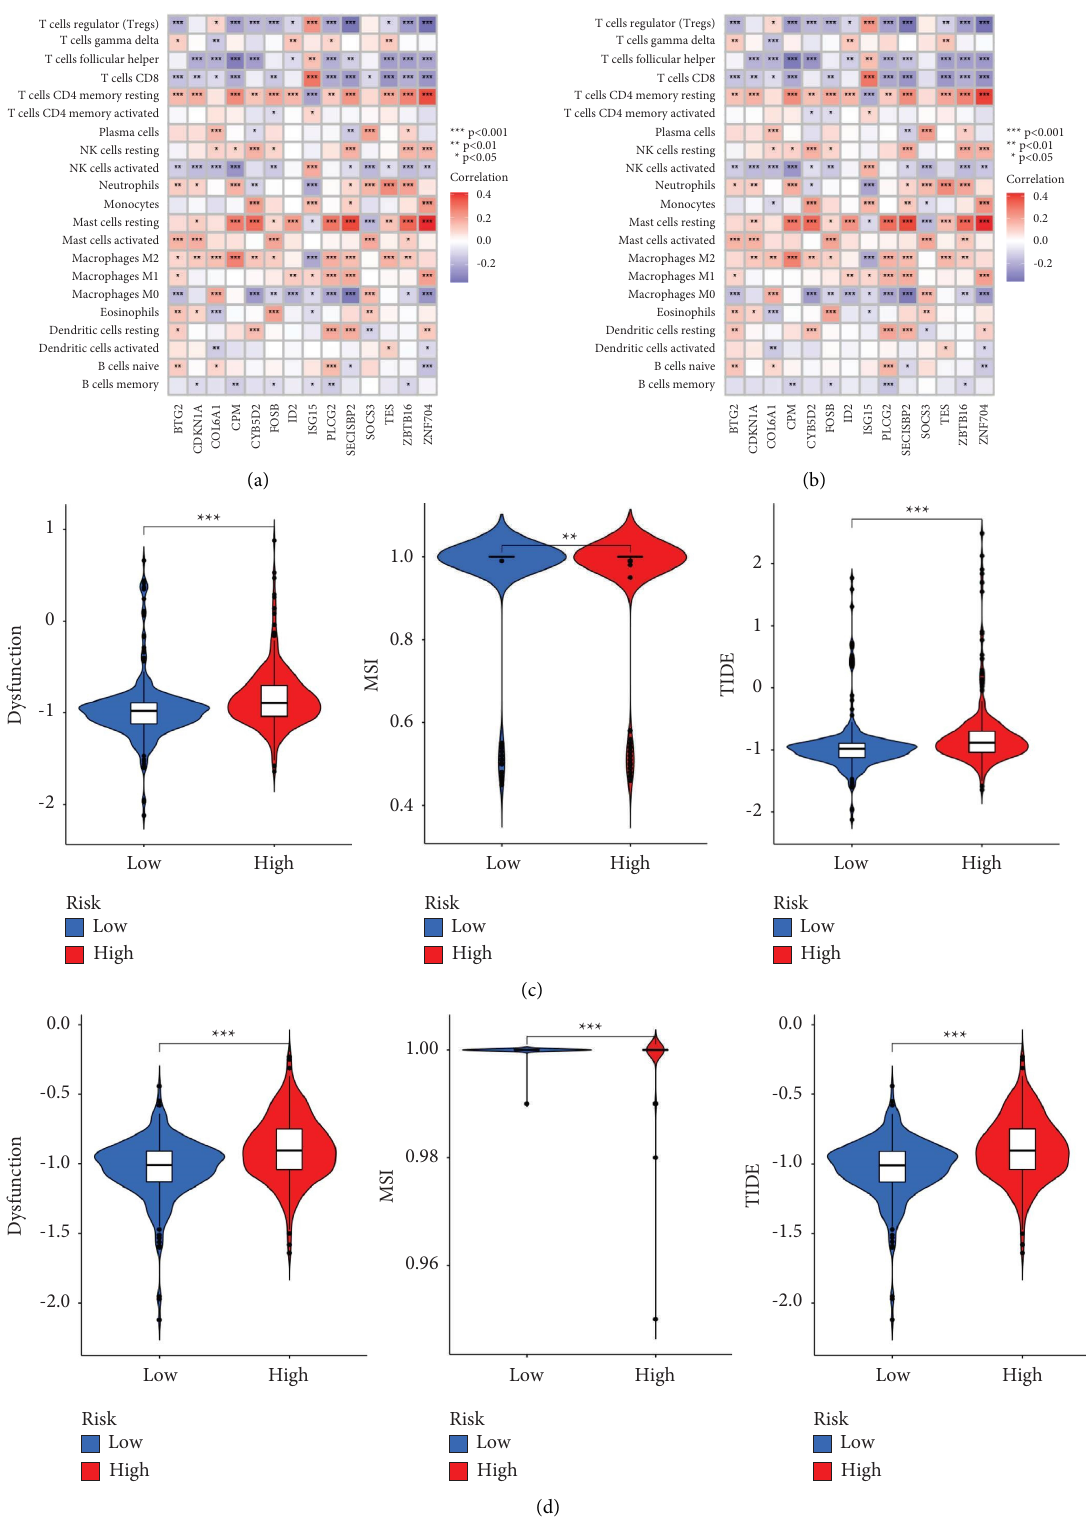
Figure 9: Prediction of immunotherapeutic response and drug sensitivity: (a–b) heatmaps of correlation between the expression levels of 14 DGRs and the abundance of infltrating immune cells in training and validation cohorts and (c–d) violin plots of immunotherapeutic response in diferent risk groups based on training and validation